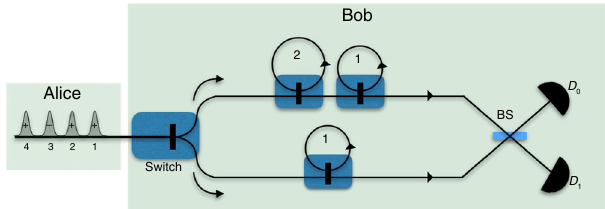
Fig. 6 The Hidden Matching problem. Alice receives an input x ∈ {0, 1} n Fig. 7 Circuit illustration for the implementation of Hidden Matching using coherent states, for matchings from the set in Fig. 2. Alice encodes